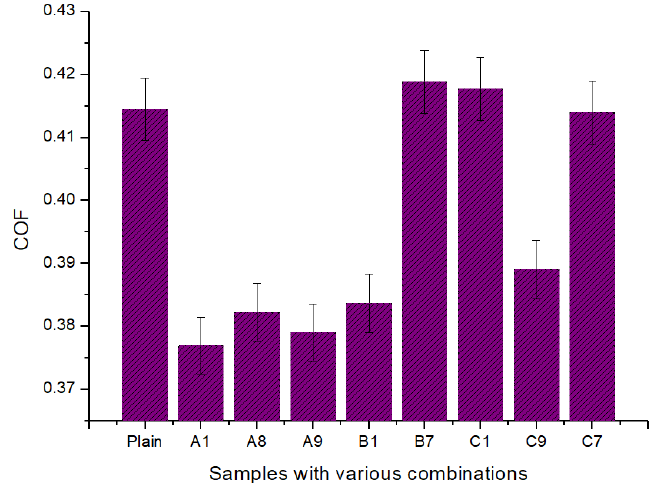
Figure 14. The coefficient of friction for various pin samples, plain pins, and treated pins.